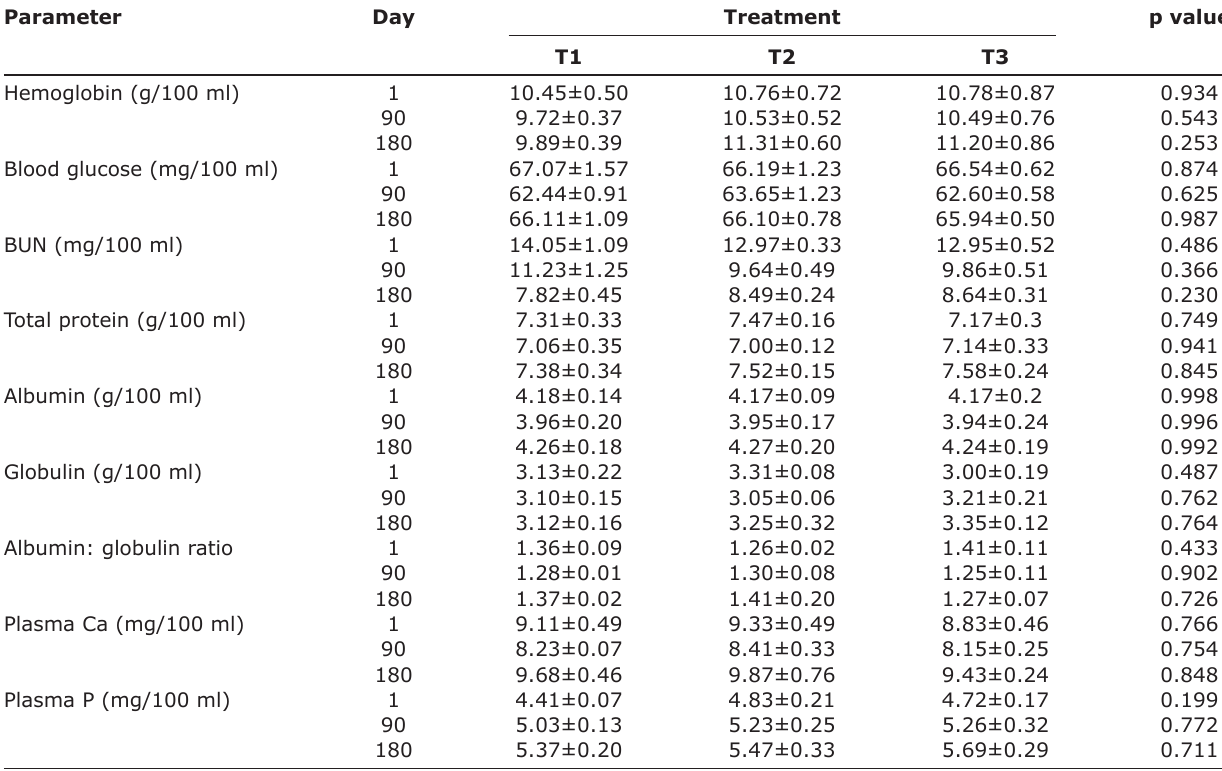
Table-3: Blood*, plasma protein* and mineral parameters* of animals maintained on the three experimental rations in Phases I and II.